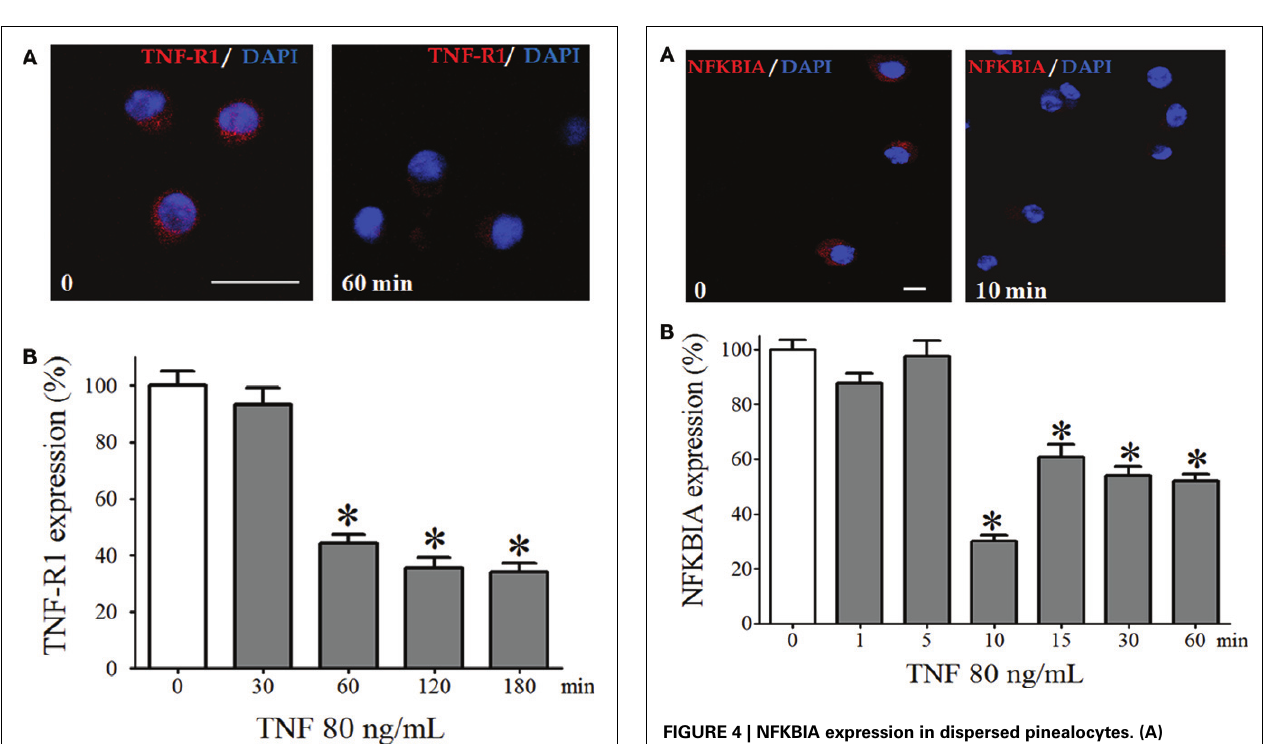
FIGURE 4 | NFKBIA expression in dispersed pinealocytes. (A) Representative immunocytochemistry images demonstrating expression of NFKBIA (stained in red) in cultured pinealocytes in the absence (left-hand panel) or in the presence ofTNF (80ng/mL, for 10min; right-hand panel). Blue staining represents the fluorescent nuclei issued with DAPI. (B) Quantification of the fluorescence of pinealocytes stimulated (gray bars) or not stimulated (white bar) withTNF (80ng/mL) for 1–60min. Data are shown as the mean ± SEM; n = 3 independent cultures. * p < 0.05 vs. no TNF (white bar). Scale bar = 10 μ